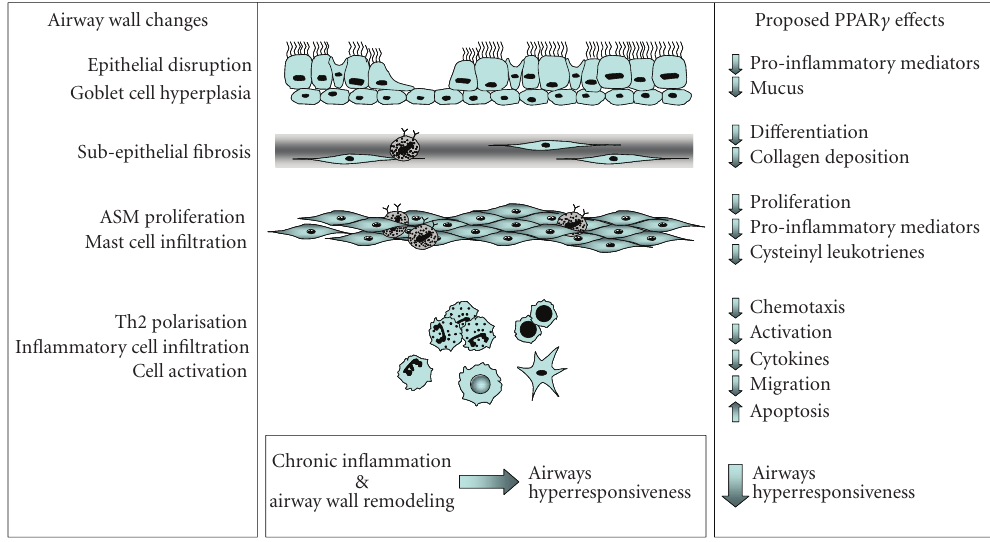
Figure 1: Proposed e ff ects of PPAR γ ligands on inflammatory and remodelling changes in the asthmatic airway that contribute to airways